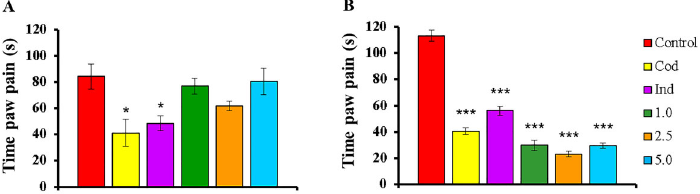
Figure 5. Effect of COPHCT in nociceptive test induced by the subplantar injection of 2.5% formalin in the hind paw of the mice. A , Phase 1 or neurogenic pain: 0 – 5 min. B , Phase 2 or in fl ammatory pain: 15 – 30 min. Data are reported as means ± SE of 5 animals per group. *P o 0.05 and ***P o 0.001 compared to the Control group, determined by analysis of variance (ANOVA) followed by Bonferroni post-hoc test. Groups: Control (PBS 10.0 mL/kg, ig ); Cod (7.5 mg/kg codeine, ig ); Ind (25.0 mg/kg indomethacin, ig ); 1.0, 2.5, and 5.0: COPHCT 1.0, 2.5, and 5.0 mg/kg, ig ).